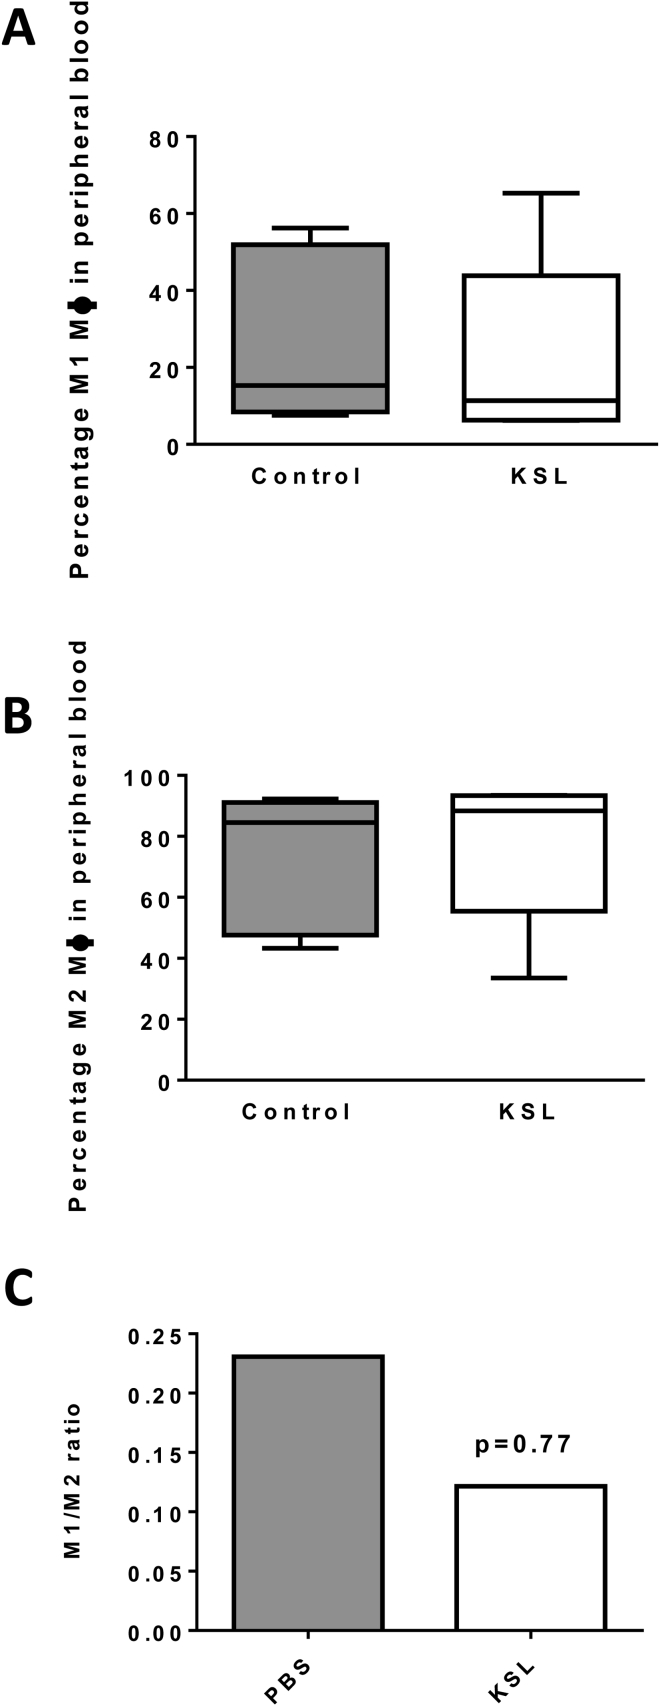
(A – C) Flow cytometric analysis of peripheral blood was performed to characterize the macrophage subsets (M1/M2) and their ratio. The following gating strategy was used: M1-macrophages (gated CD45+CD3-CD11b+F4/80+Ly-6G-Ly6Chi) and M2-macrophages (gated CD45+CD3-CD11b+F4/80+Ly-6G-Ly6-Clo). Data are expressed as median ± interquartile range. PBS, phosphate-buffered saline.